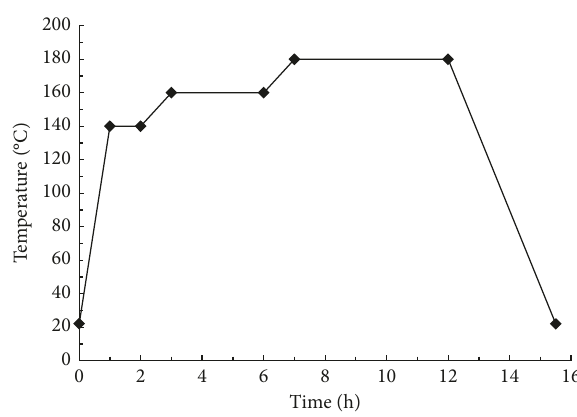
Figure 3: Heat-treatment process for preparation of friction composites [28].